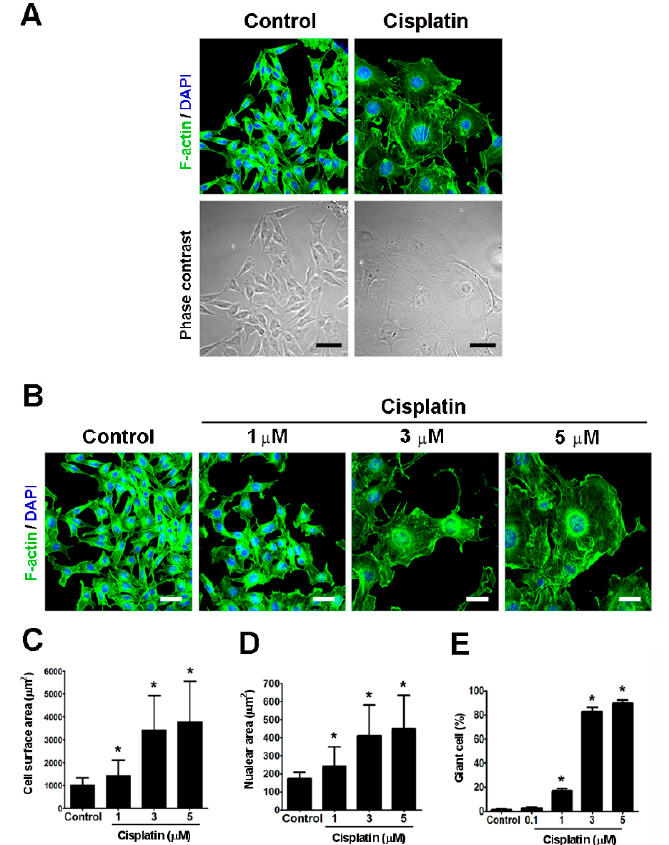
Figure 2. Cisplatin induced the formation of giant cells in vitro. ( A ) B16-F10 cells were treated with 3 μ M cisplatin for 48 h and were stained with phalloidin to visualize the actin filaments (green), and the nuclei were stained with DAPI (blue). The fluorescence and phase contrast images were examined under the same field. Scale bar, 50 μ m. ( B ) Cells were treated with different doses of cisplatin (1~5 μ M) for 48 h. The fixed cells were stained with phalloidin (green) and the DAPI (blue). Scale bar, 50 μ m. ( C ) and ( D ) The cell surface and nuclear areas were determined by software (the measured cell number > 100, each group). ( E ) The percentage of giant cells was examined after 48 h exposure to 0.1 to 5 μ M cisplatin. The counted cell number in each group was > 300. * p < 0.01 compared with the control cells.